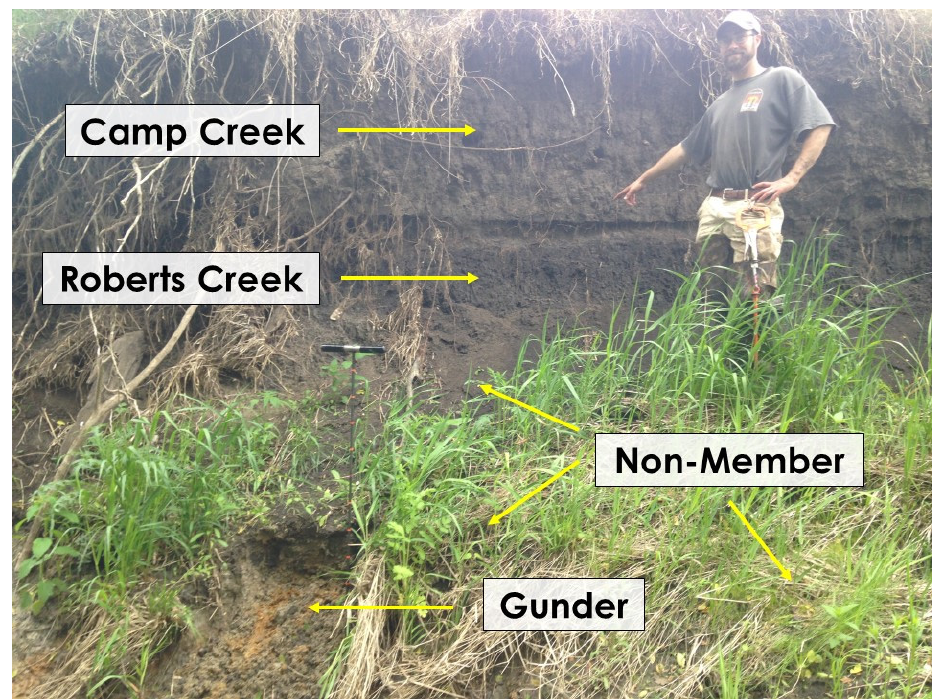
Figure 5. A streambank with all four materials of interest present, Walnut Creek, Iowa. Note the fully exposed Camp Creek and partially exposed Roberts Creek. The Gunder was completely draped by non-member material (NMM), and exposed using a shovel. Photo credit: Hanna McBrearty, Iowa State University.